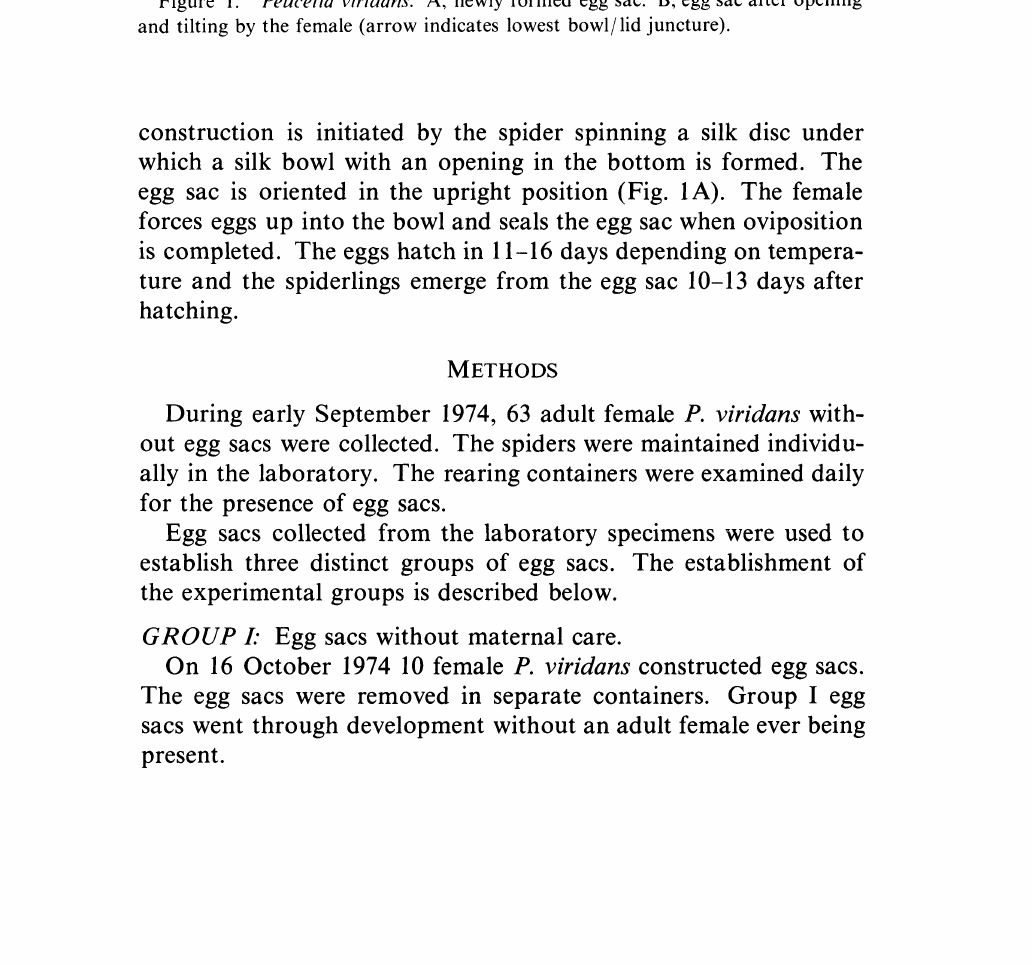
Figure 1. Peucetia viridans. A, newly formed egg sac. B, egg sac after opening and tilting by the female (arrow indicates lowest bowl/lid